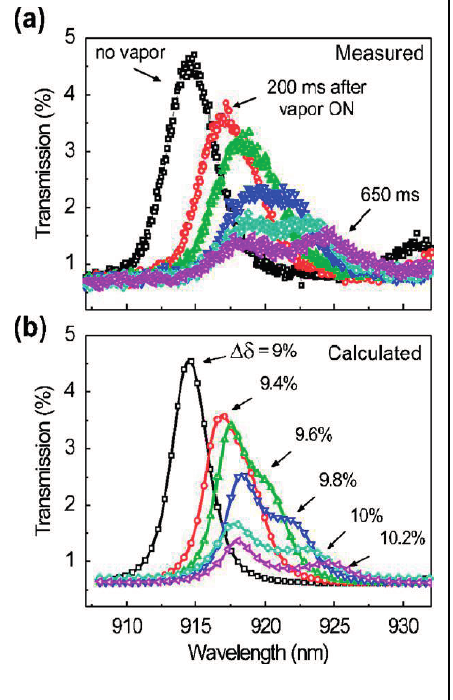
Figure 6. Vapor induced splitting of the Zener tunneling peak. ( a ) Experimental spectra of the sample exposed to ethanol vapors, ( b ) transfer-matrix calculations. The original double resonance peak splits into two separate modes when the built-in tilting is modified by the external “field”, mimicked by the refractive index gradient induced by the ethanol vapor flow. Reprinted with permission from Reference [66]. Copyright 2006 American Physical